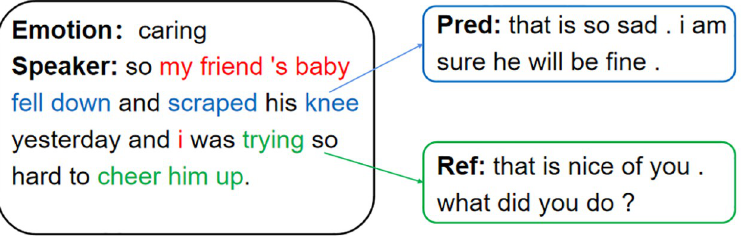
Fig 1. A comparative example from the EMPATHETIC DIALOGUES dataset compares the standard responses with the KEMP model responses.